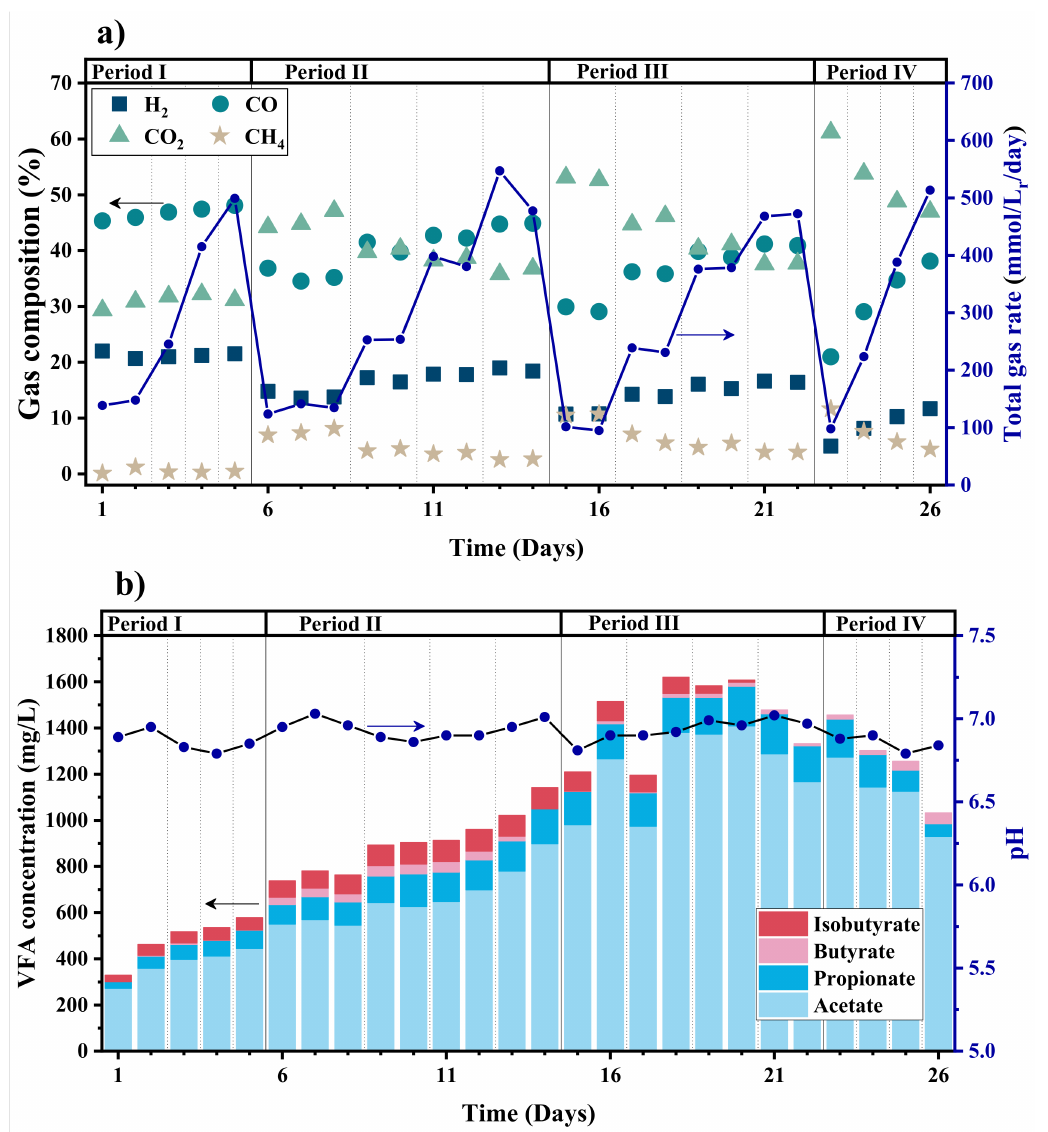
Figure 3. ( a ) Composition and rate of output gas, and ( b ) VFA concentration and pH in the CSTR during syngas biomethanation (The whole test time is divided by 4 periods with different stirring speeds, and each period is divided by dotted lines with different GRT of 2.5, 1.25, 0.833, and 0.625 h from left to